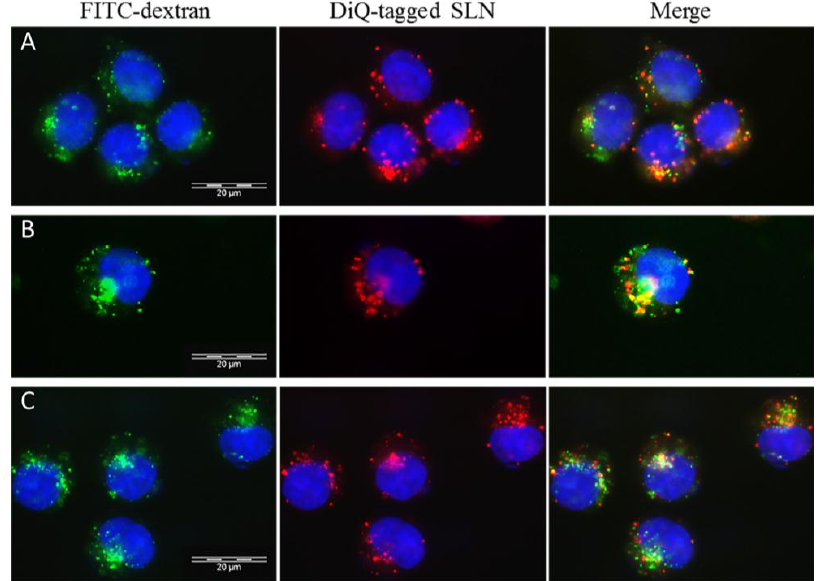
Figure 8. Cell uptake of fluorescent-SLN. Fluorescence microscopy images of SH-SY5Y cells were taken 1( A ), 2 ( B ) and 4 h ( C ) after treatment with 500 nM DiQ-tagged Rp-SLN DiQ (red) and after staining of lysosomes with fluorescein isothiocyanate dextran (green). Nuclei were stained with 4',6-diamidino-2-phenylindole (DAPI). Magnification: 60×.